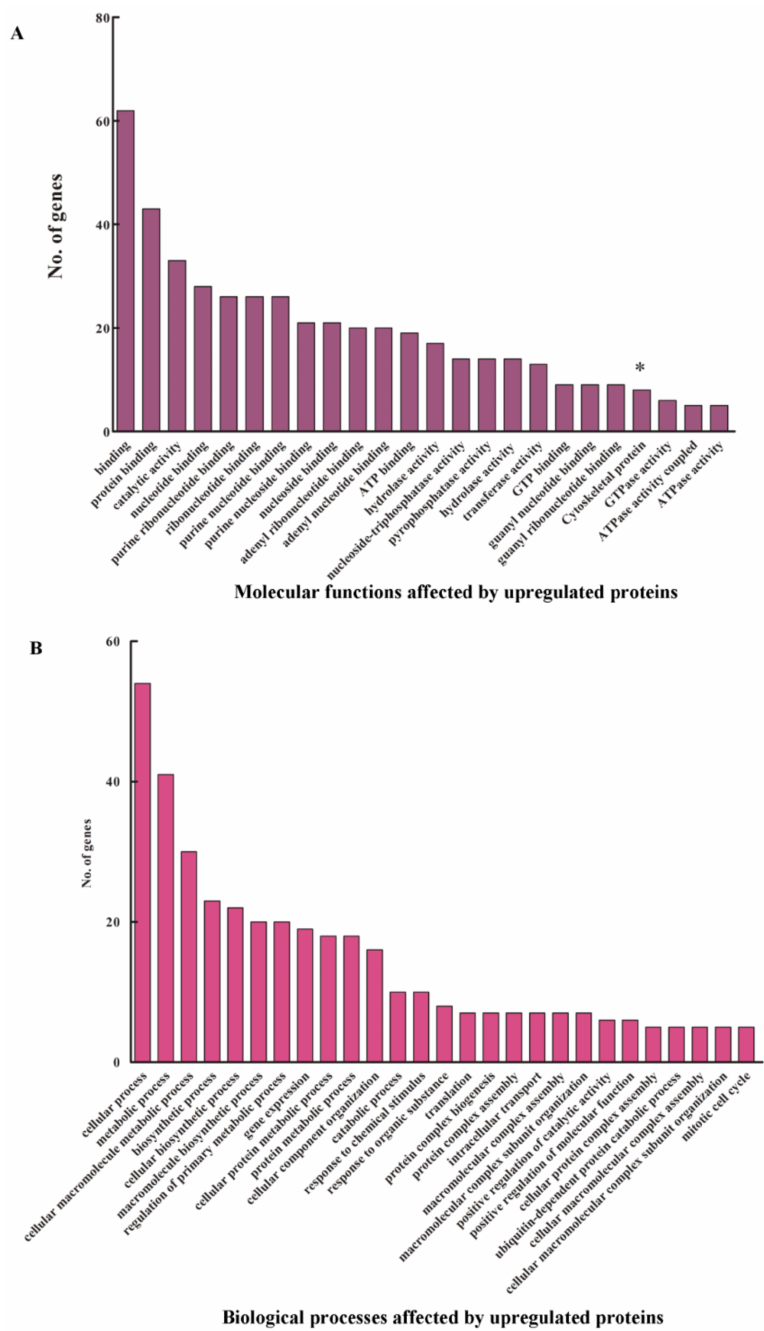
Figure 3. Analysis of the upregulated proteins. Gene Ontology terms. ( A ) Molecular functions and ( B ) biological processes enriched upon α -fodrin downregulation. * in ( A ) indicates genes enriched in cytoskeletal